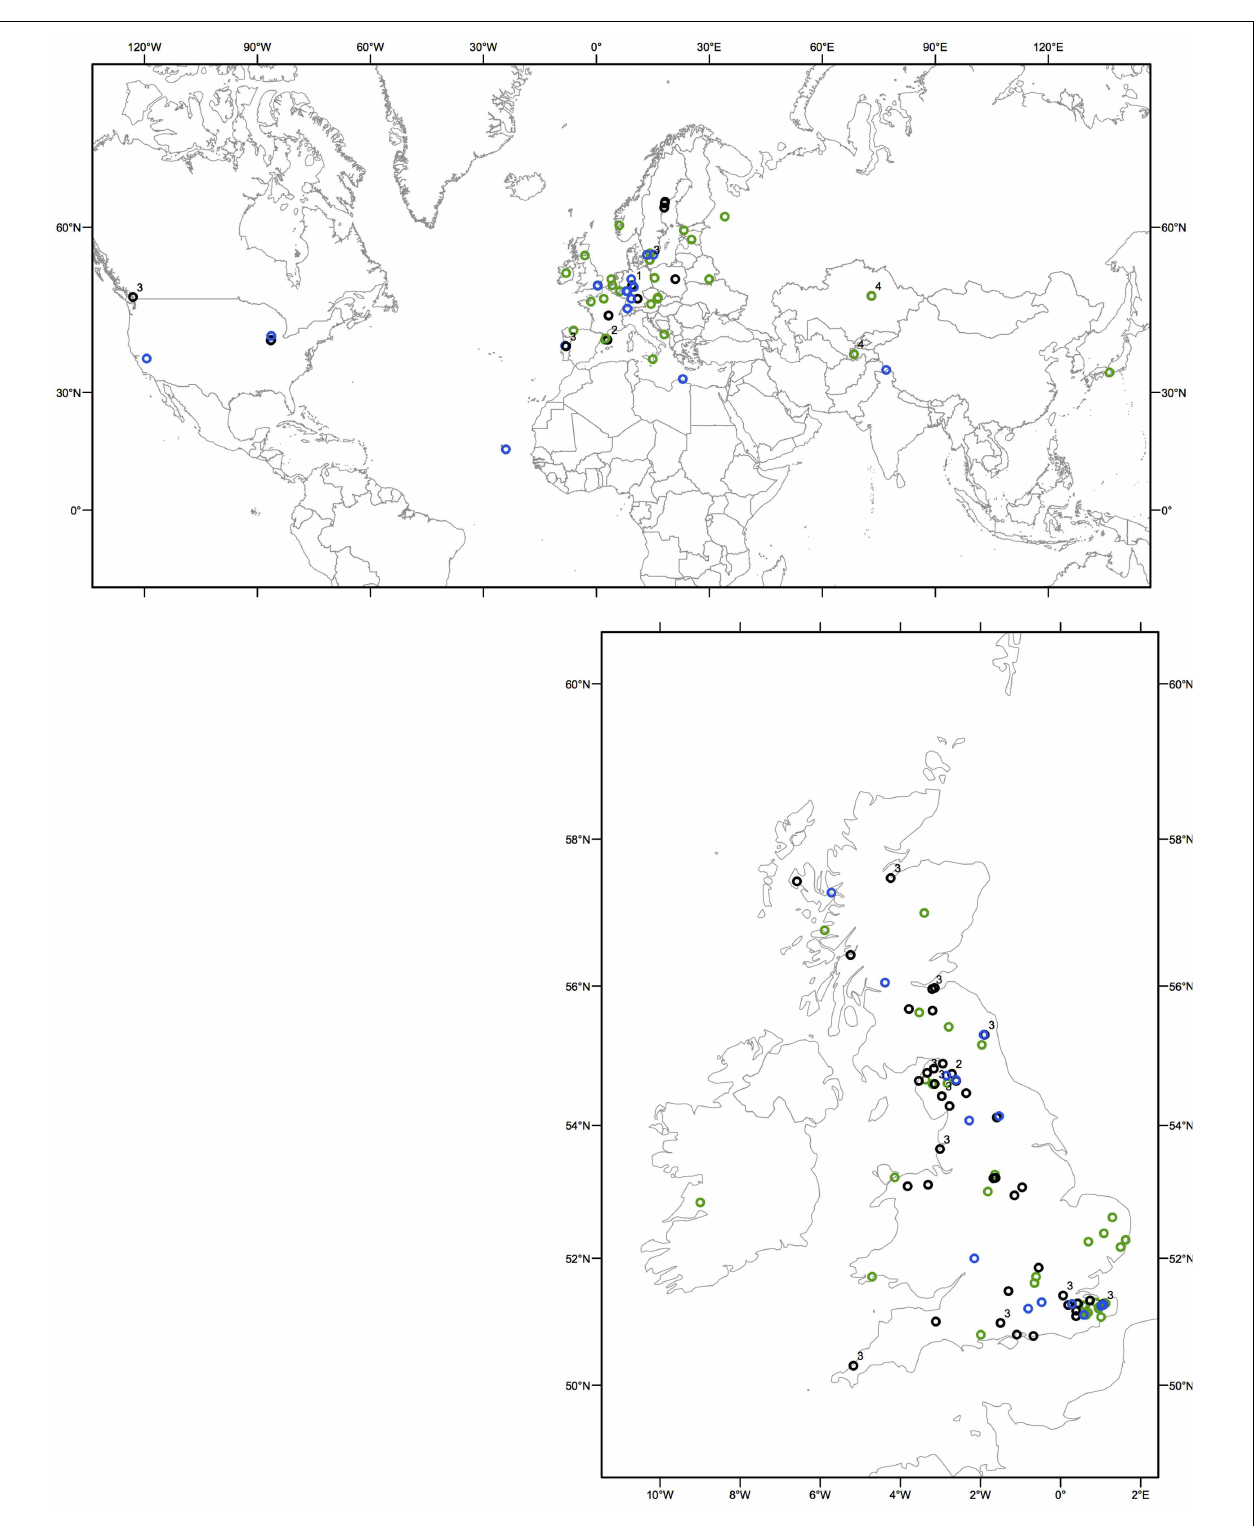
FIGURE 1 | Geographical distribution of resistant and susceptible individuals determined from HR and PCR. Resistant accessions are represented by light green open circles, rpm1-deletion nulls by blue open circles.The susceptible accessions containing RPM1 genes with premature stop codons are represented by black open circles. Next to these circles, the type of the loss-of-function allele (allele types 1 through 4 as defined in Figure 2 ; Table 1 ) is indicated.